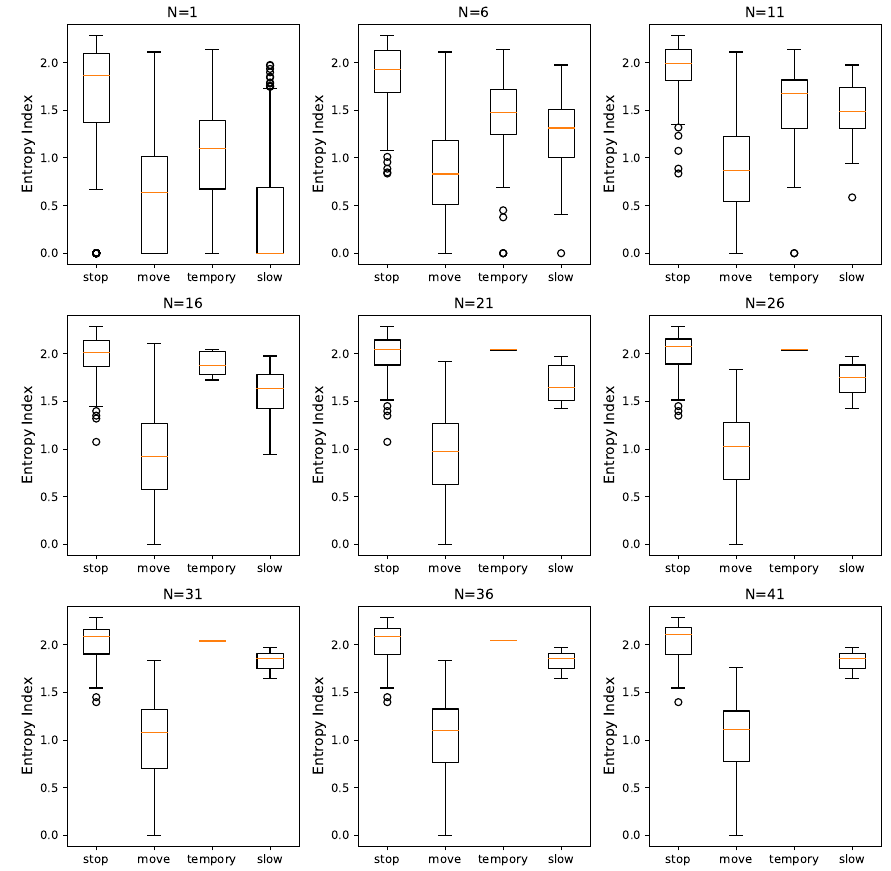
Figure 6. Box plot of entropy index for GPS pieces with different minimum